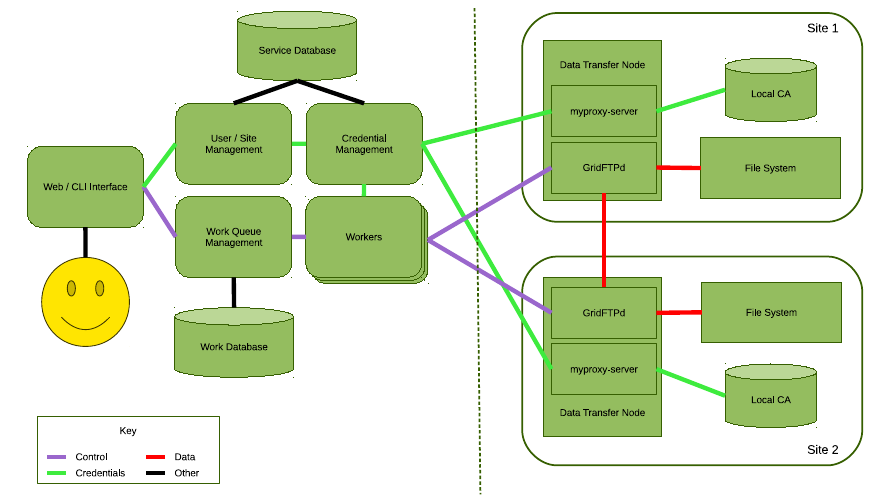
Figure 1. A schematic of the data transfer